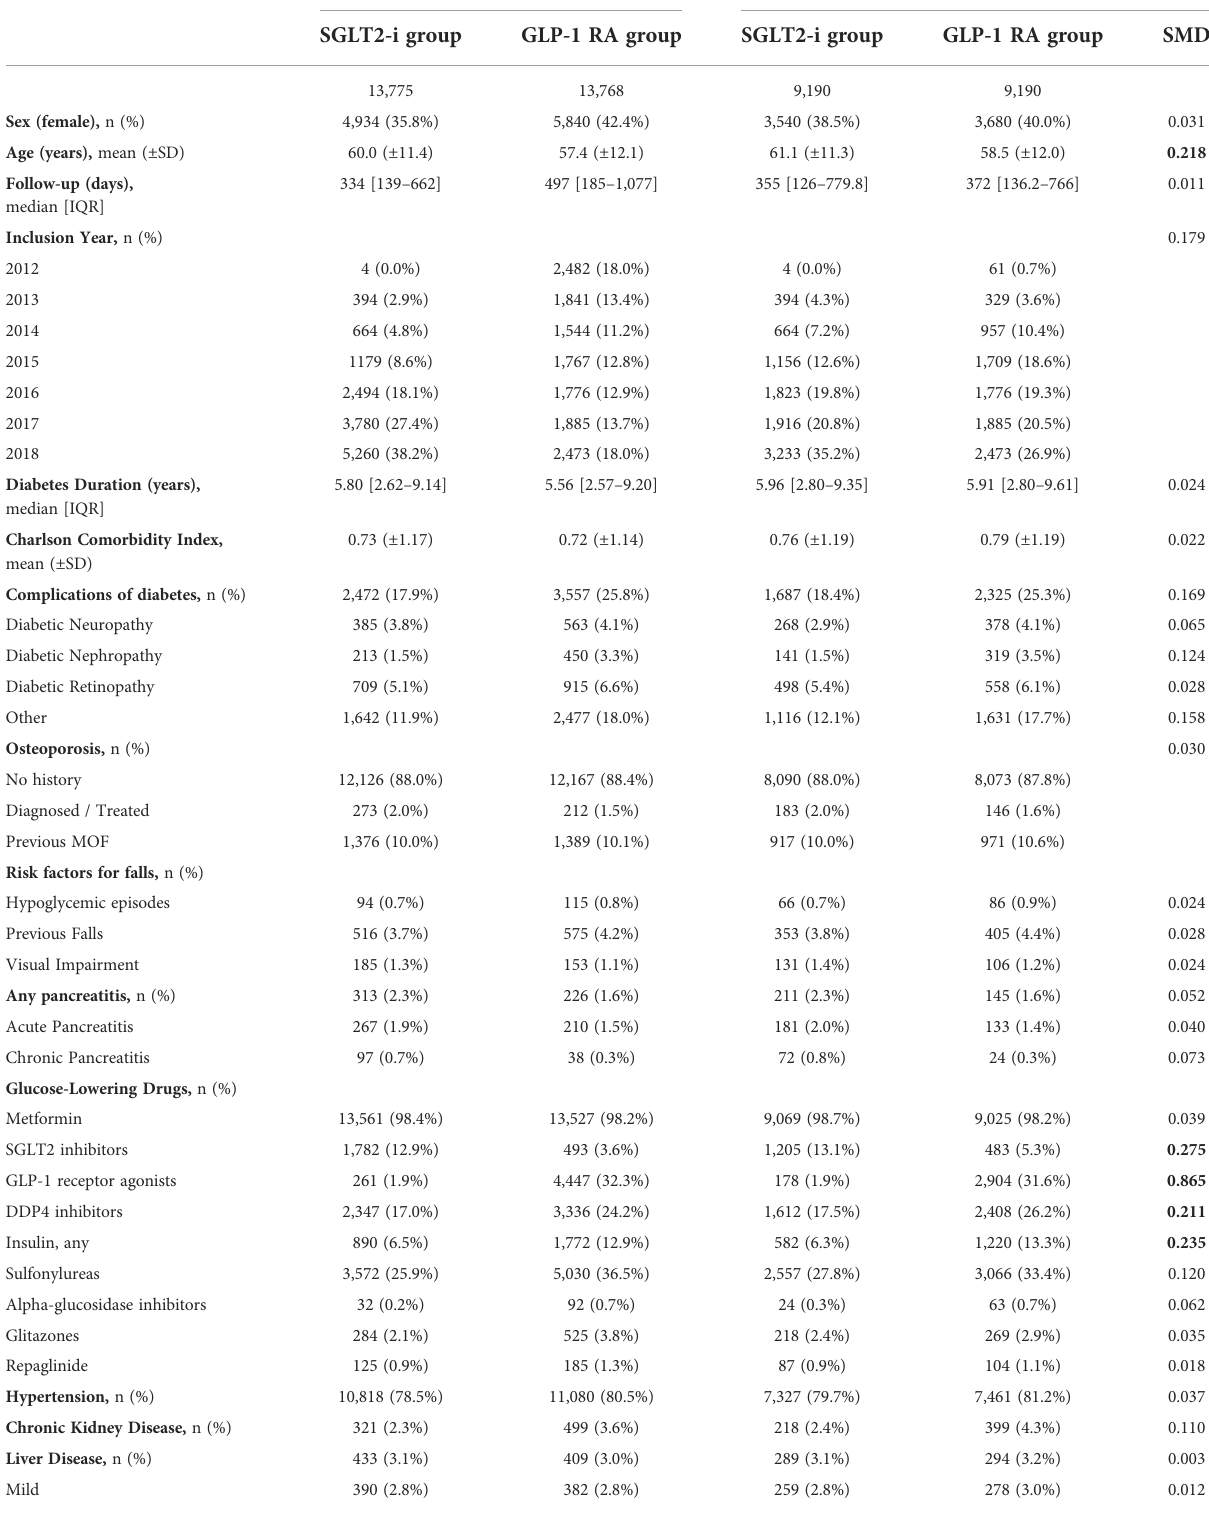
TABLE 1 Baseline Characteristics of Full and Matched